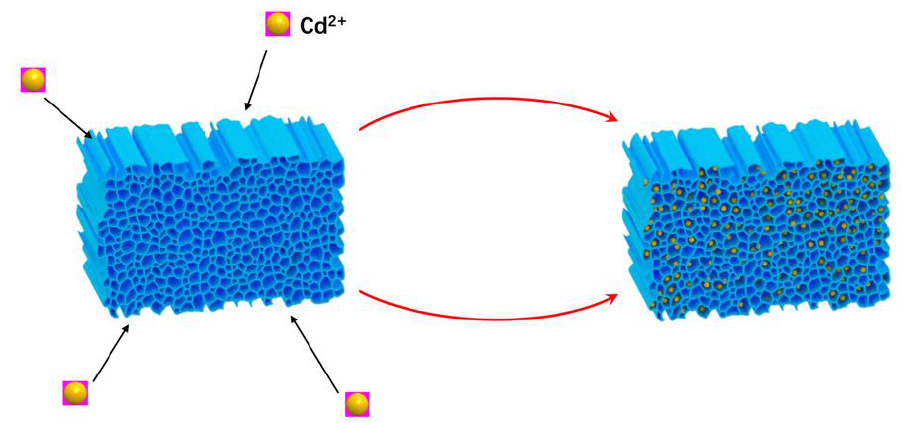
Figure 2. Schematic diagram of the possibility of the superiority of GBB adsorption.